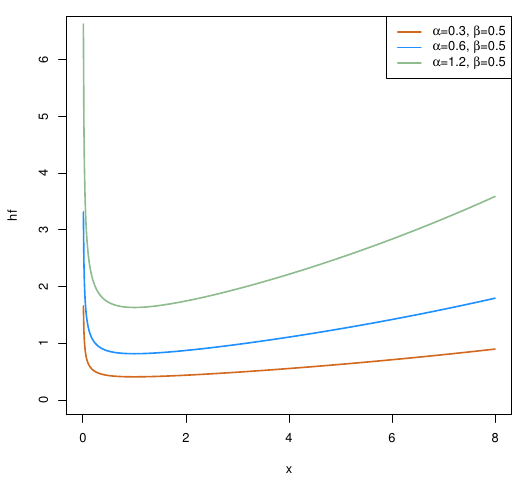
Figure 5. The hf when 0 < β < 1.